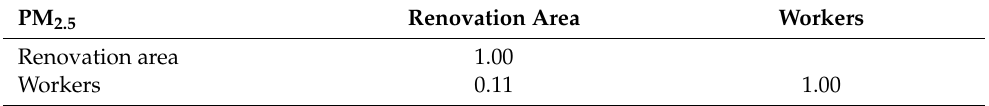
Table 5. Correlation coefficient (r) between PM 2.5 and workers in the renovation area. PM 2.5 Renovation Area Workers Renovation area 1.00 Workers 0.11 1.00